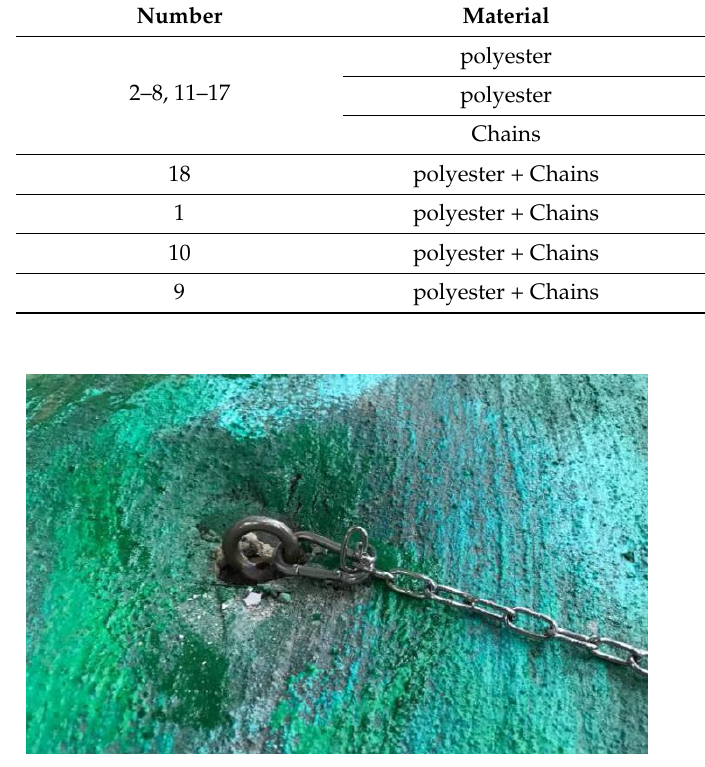
Figure 19. Anchorage point on the reef.